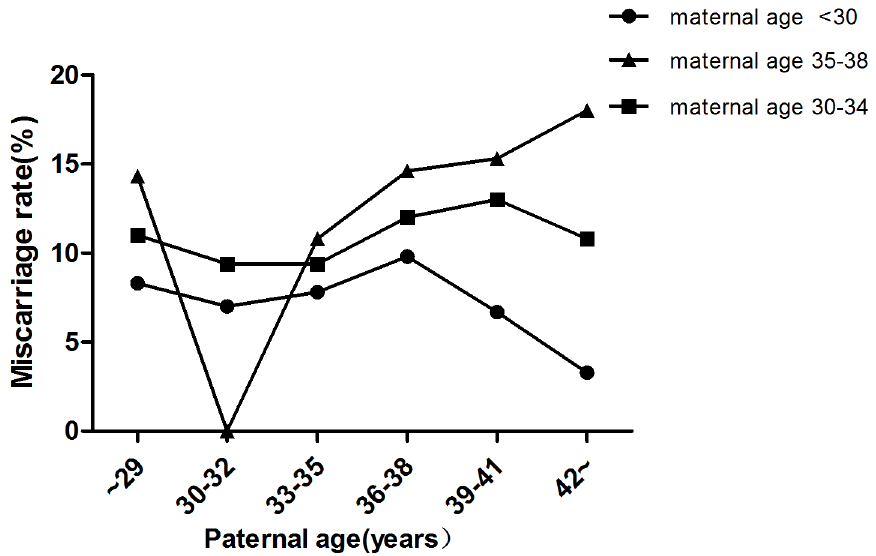
Fig 3. Miscarriage rates in different age groups. In each group (maternal age < 30 y, 30 – 34 y, 35 – 38 y), there were no significant differences in miscarriage rate among different paternal age subgroups ( P > 0.05).